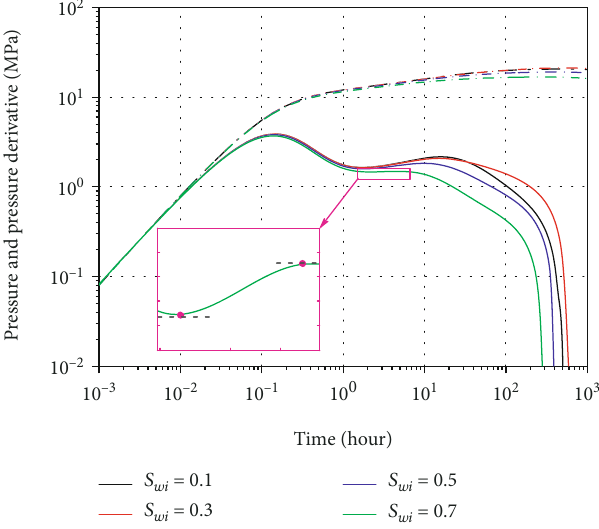
Figure 13: E ff ect of initial water saturation on pressure transient response. S is the initial water wi